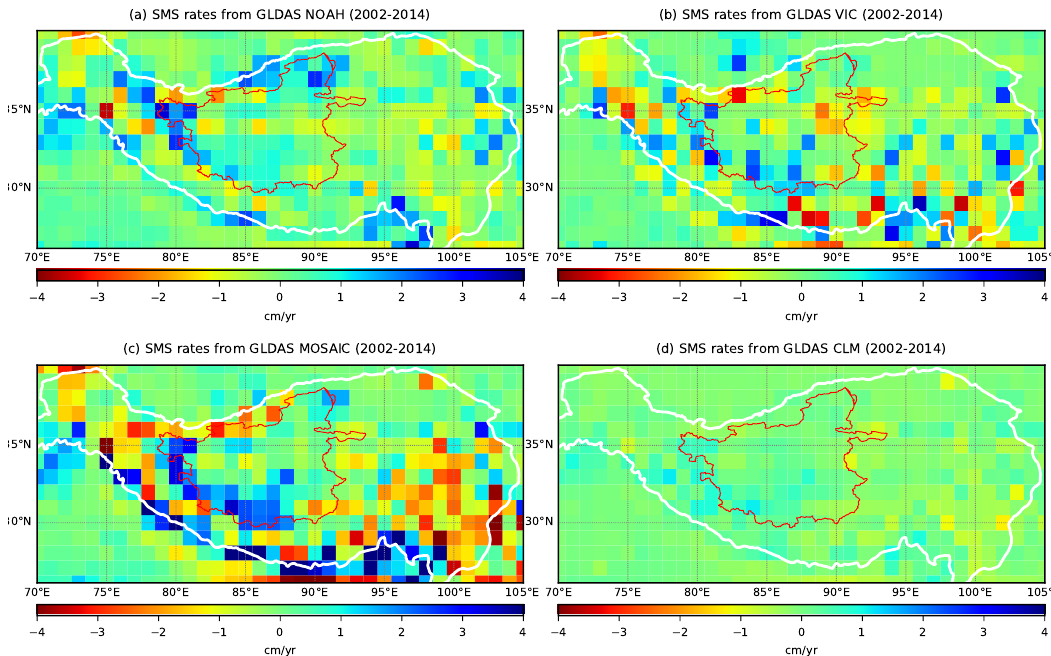
Figure 13. SMS rates from GLDAS LSMs during 2002–2014 with the versions of ( a ) NOAH, ( b ) VIC, ( c ) MOSAIC, and ( d )